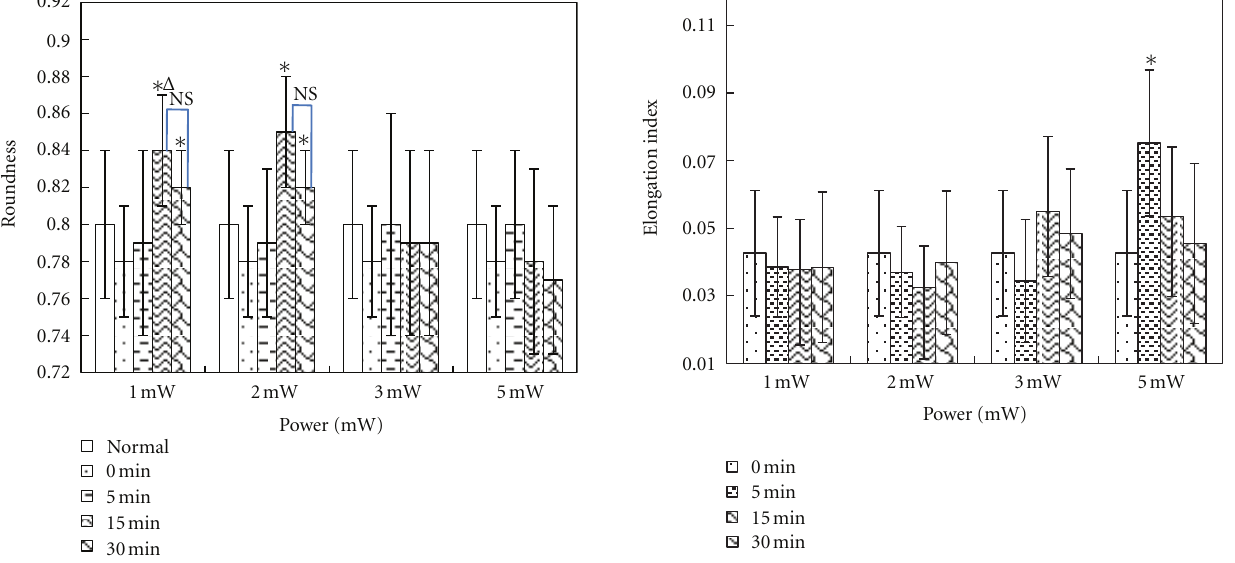
Figure 3: E ff ects of laser irradiation on roundness of dehydrated erythrocytes. Data are means ± SD. N = 100. ∗ P < 0 . 05 versus the no irradiation group as control. Triangles indicate significant di ff erences between the group of 15 min × 1mW and the group of 5min × 3mW, Δ P < 0 . 05, and NS indicate no significant di ff erences between the two groups.